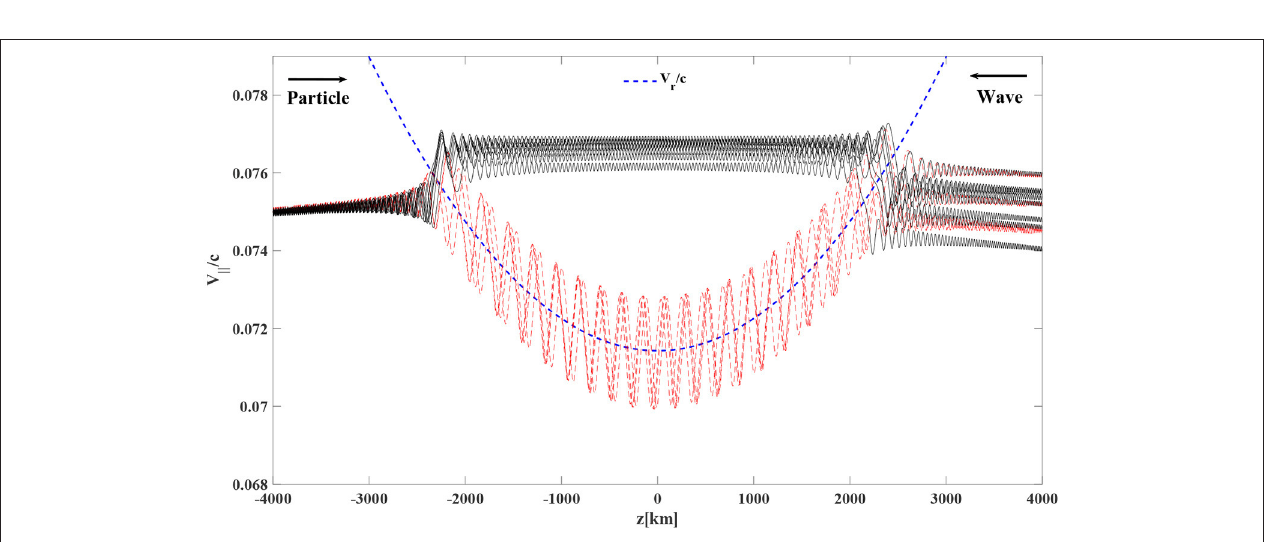
FIGURE 8 | Trajectories of trapped (red) and untrapped (black) electrons with uniformly distributed initial gyro-phase. The wave is assumed to be constant amplitude and